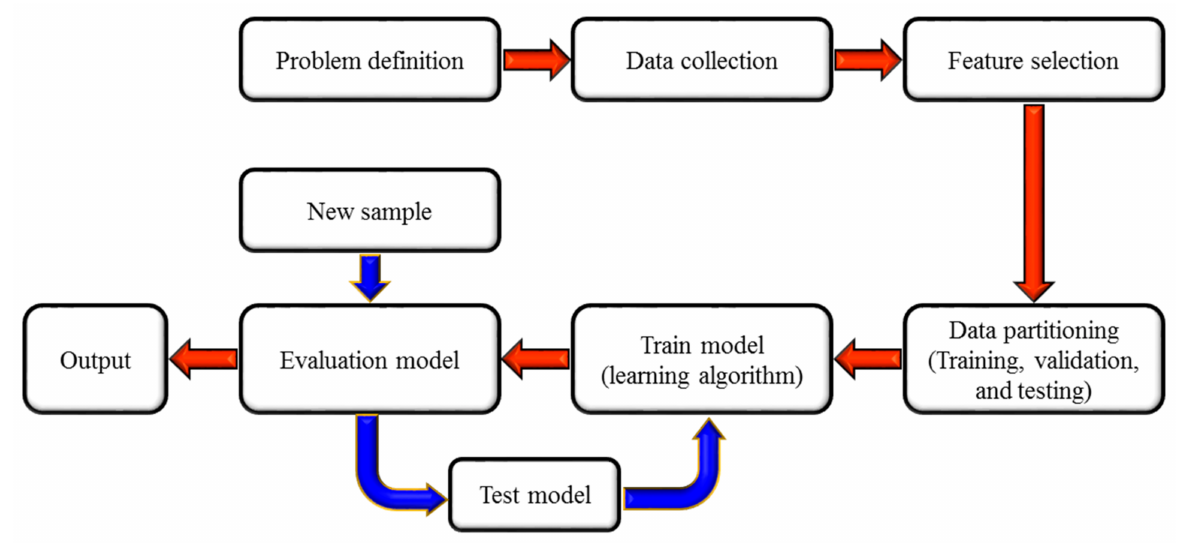
Figure 7. Machine learning implementation stages.